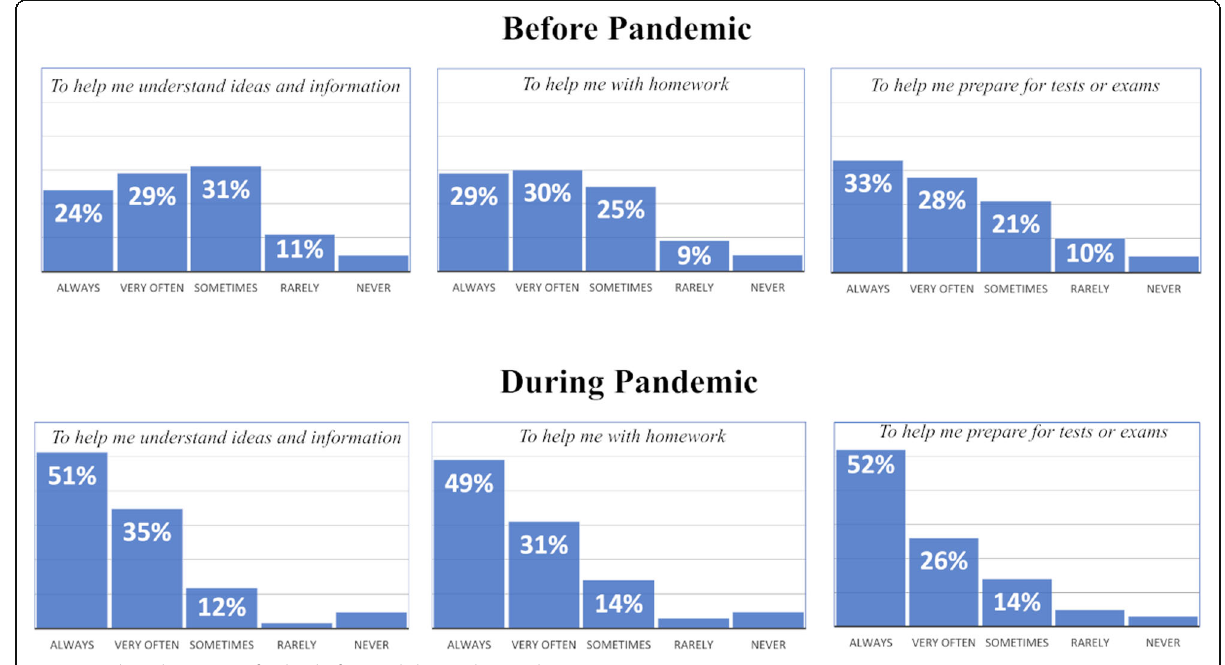
Fig. 7 Student-driven use of video before and during the